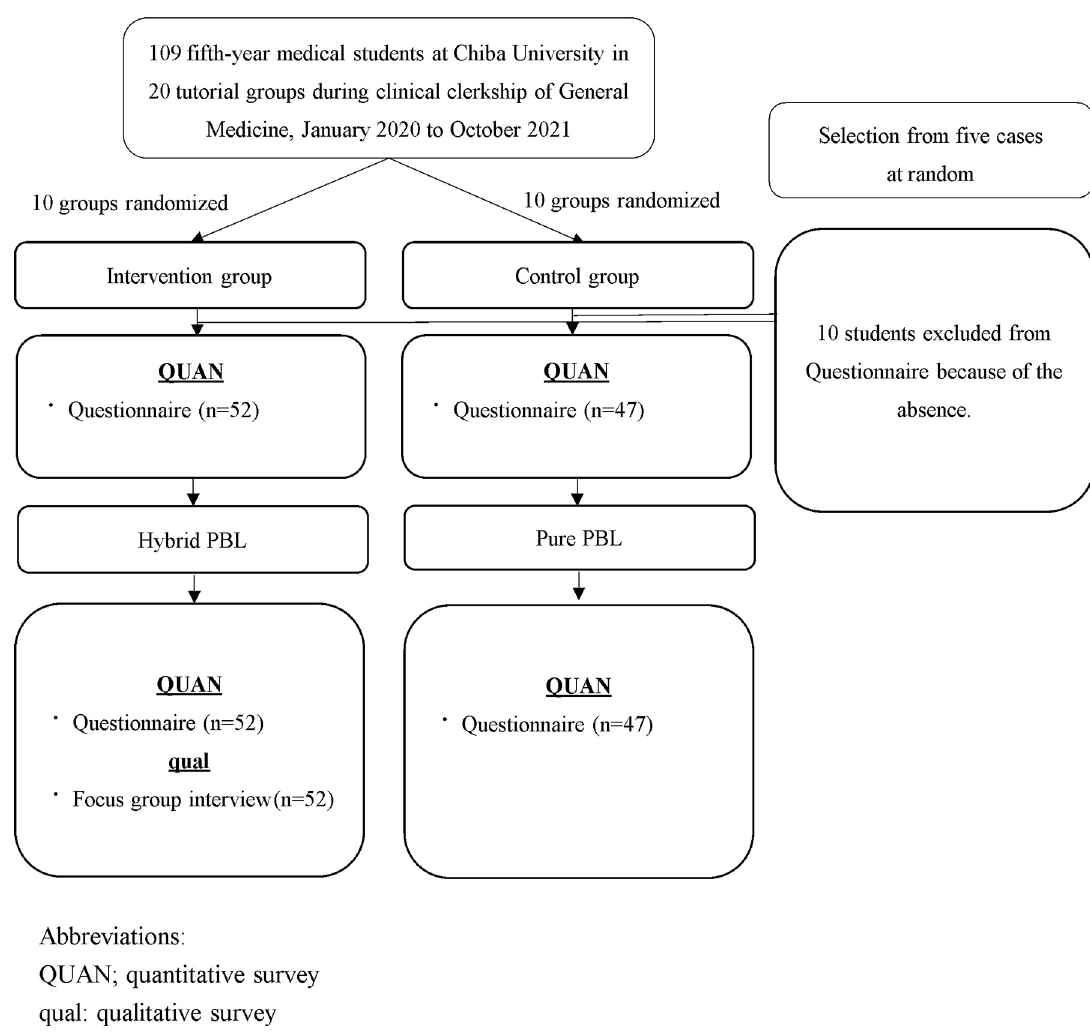
Fig 1. Flow diagram of the